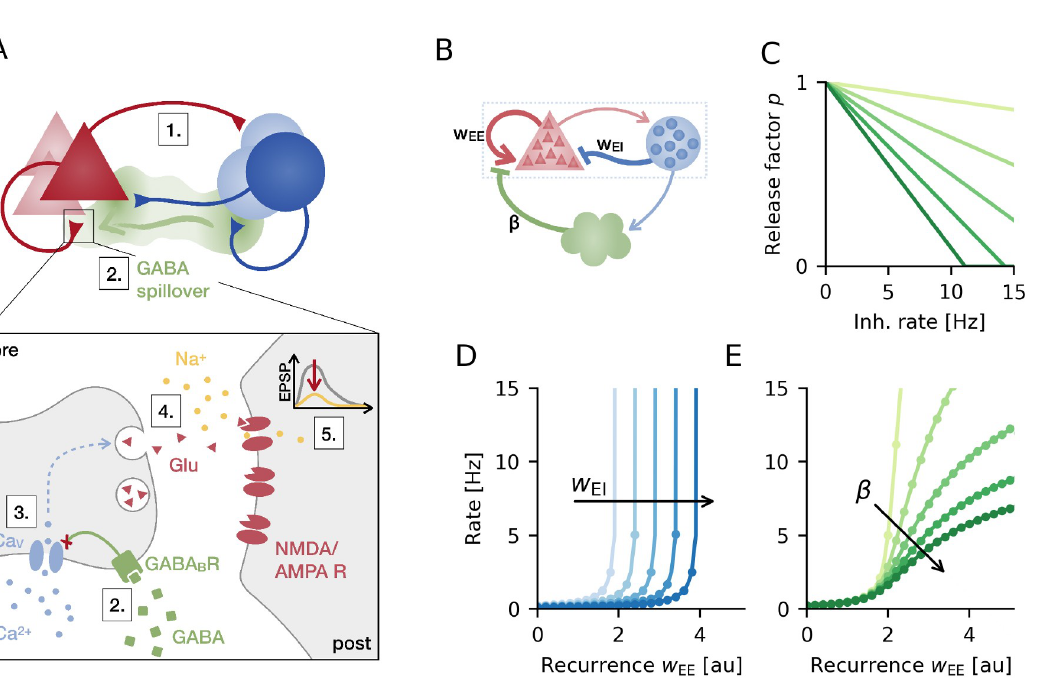
Fig 1. Presynaptic inhibition in a recurrent network. A . Presynaptic inhibition mechanism: (1) Network activity drives inhibitory interneurons. (2) GABA released by interneurons can spill over to nearby excitatory synapses, where it binds to presynaptic GABA B receptors that (3) in turn inhibit voltage-sensitive Calcium (Ca 2+ ) channels. (4) Reduced Ca 2+ influx decreases the release of neurotransmitter Glutamate and (5) therefore the amplitude of EPSPs. B . Simplified rate-based model consisting of excitatory (red) and inhibitory population (blue) and a presynaptic inhibition mechanism (green). C . Release factor as a linear function of inhibitory neuron activity for different slopes β = 0.01, 0.03, ... , 0.09. D . Population rate as a function of excitatory recurrence ( w EE ) without presynaptic inhibition for increasing strength of postsynaptic inhibition (weight w EI = 1, 1.5, ... , 3). E . Same as D but for fixed postsynaptic inhibition and increasing strength of presynaptic inhibition (slope of transfer function β , see C). Markers are simulation results and solid lines analytically determined steady-state rates (see Methods and models).